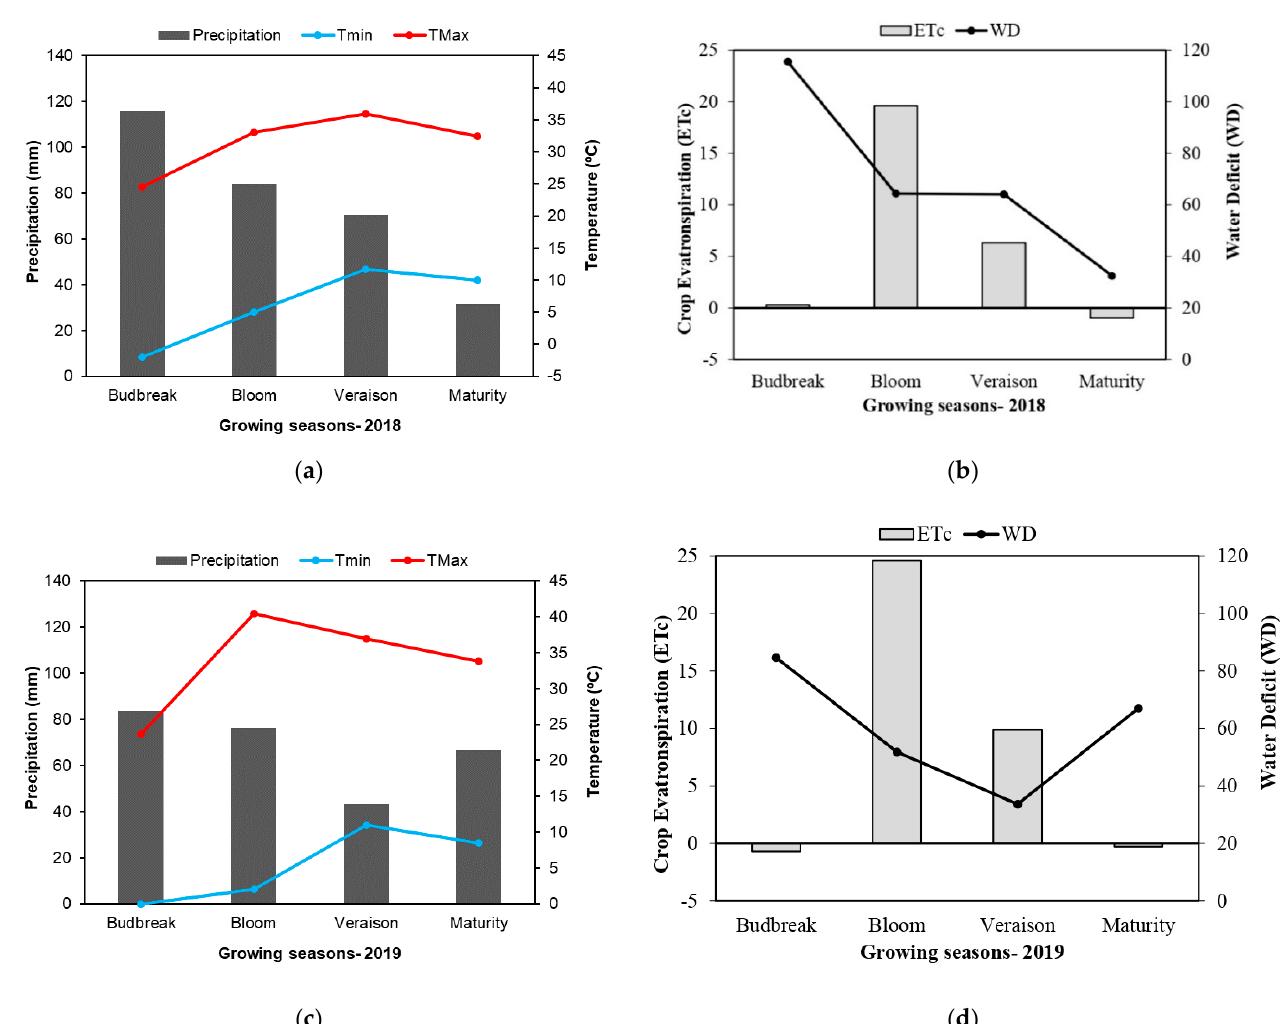
Figure 1. Precipitation, maximal temperature (T Max ), minimal temperature (T min ), ( a ) calculated crop evapotranspiration (ETc), and water deficit (WD) ( b ) of the vineyard in 2018. Precipitation, maximal temperature (T Max ), minimal temperature (T min ), ( c ) calculated crop evapotranspiration (ETc), and water deficit (WD) ( d ) of the vineyard in 2019.